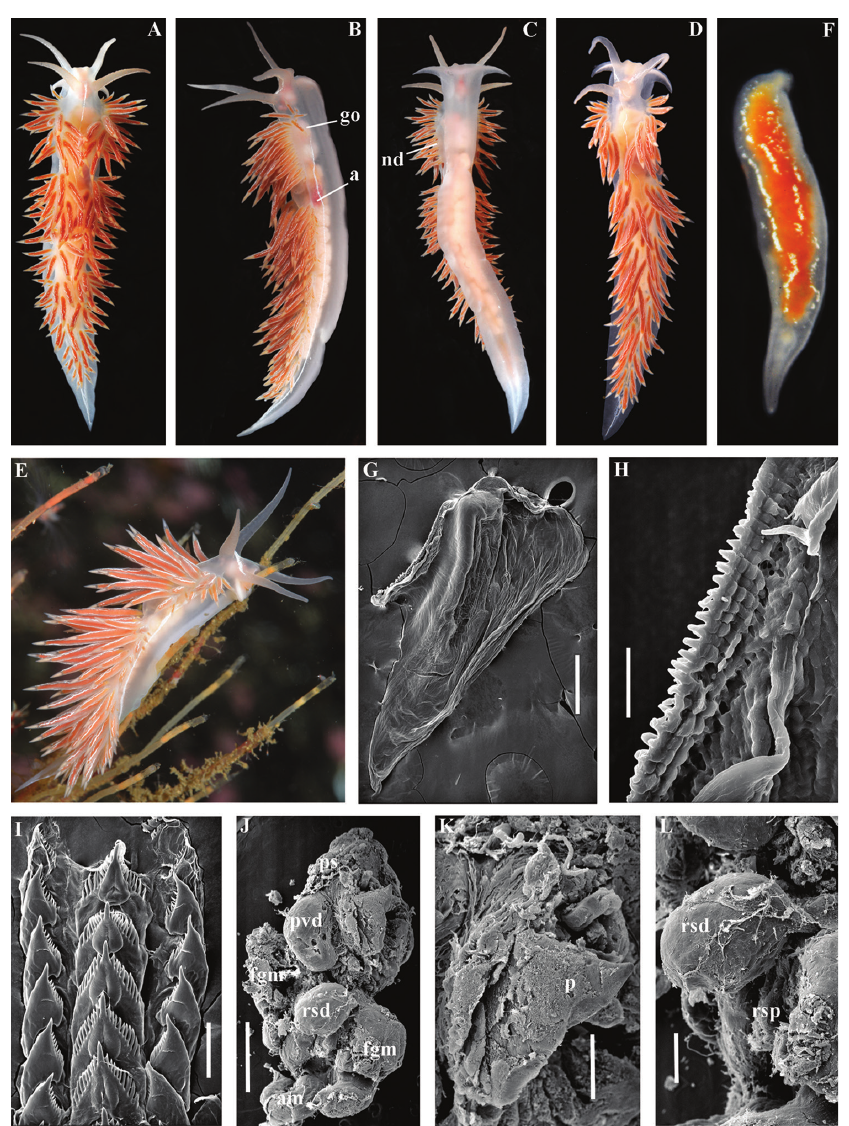
Figure 23. Fjordia chriskaugei sp. n. A–C, F Holotype ZMMU Op-477, living specimen 45 mm length, Norwegian Sea, Gulen Dive Center: A dorsal view B lateral view C ventral view F same, details of cerata D Paratype ZMMU Op- 412, living specimen 42 mm length, dorsal view, Gulen E living specimen on a hydroid colony, ZMMU Op-499, Ireland G–L Paratype ZMMU Op-405, details of living specimen 30 mm length, Gulen G jaw, SEM H details of masticatory process of jaw I radular teeth, posterior part, SEM J reproductive system, SEM K penis, SEM L seminal reservoirs, SEM. Abbreviations: a anus am ampulla rsd distal receptaculum seminis fgm female gland mass go genital opening nd discontinu- ous notal edge p penis ps penial sheath pvd prostatic vas deferens rsp proximal receptaculum seminis. Scale bars: G, K, L = 300 μm; H = 30 μm; I = 100 μm; J = 1 mm. Photos of living specimens by T.A. Korshunova ( A–D ), and B. Picton ( E ), SEM images by A.V.